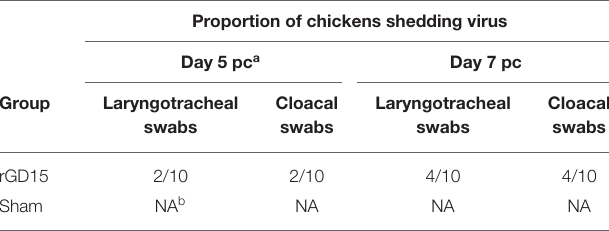
TABLE 2 | Virus shedding of chickens immunized with inactivated H7N9